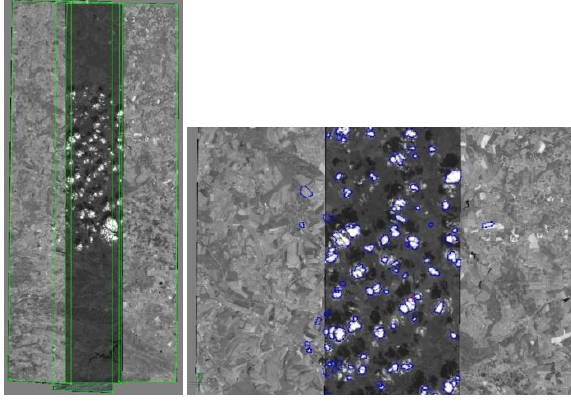
Figure 7. A Sample block of 4 images and cloud detection